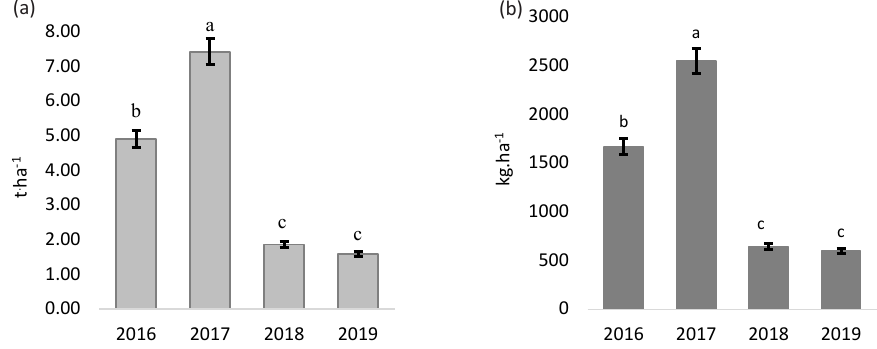
Fig. 1. Dynamics of the white lupin seed (a) and protein (b) yield in the research years. Means ± standard error followed by the same letters are not significantly different at p < 0.05.